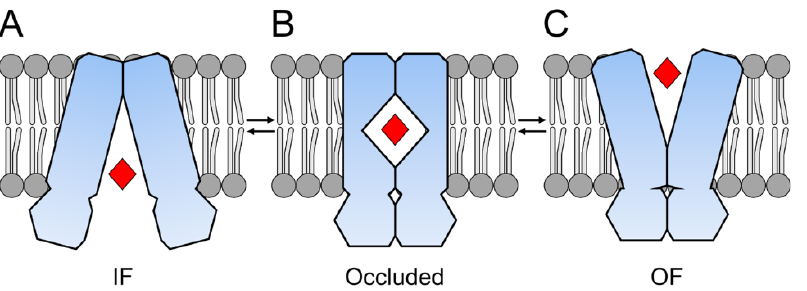
Figure 2. Schematic of a transport cycle of a type IV ABC exporter. ( A ) : In the inward-facing (IF) conformation, the transporter binds the substrate. ( B ) : During substrate translocation across the membrane, the occluded state is formed with the substrate pocket closed to the inside and outside. ( C ) : The transporter adopts the outward-facing (OF) conformation, and the substrate leaves the transporter to the outside.